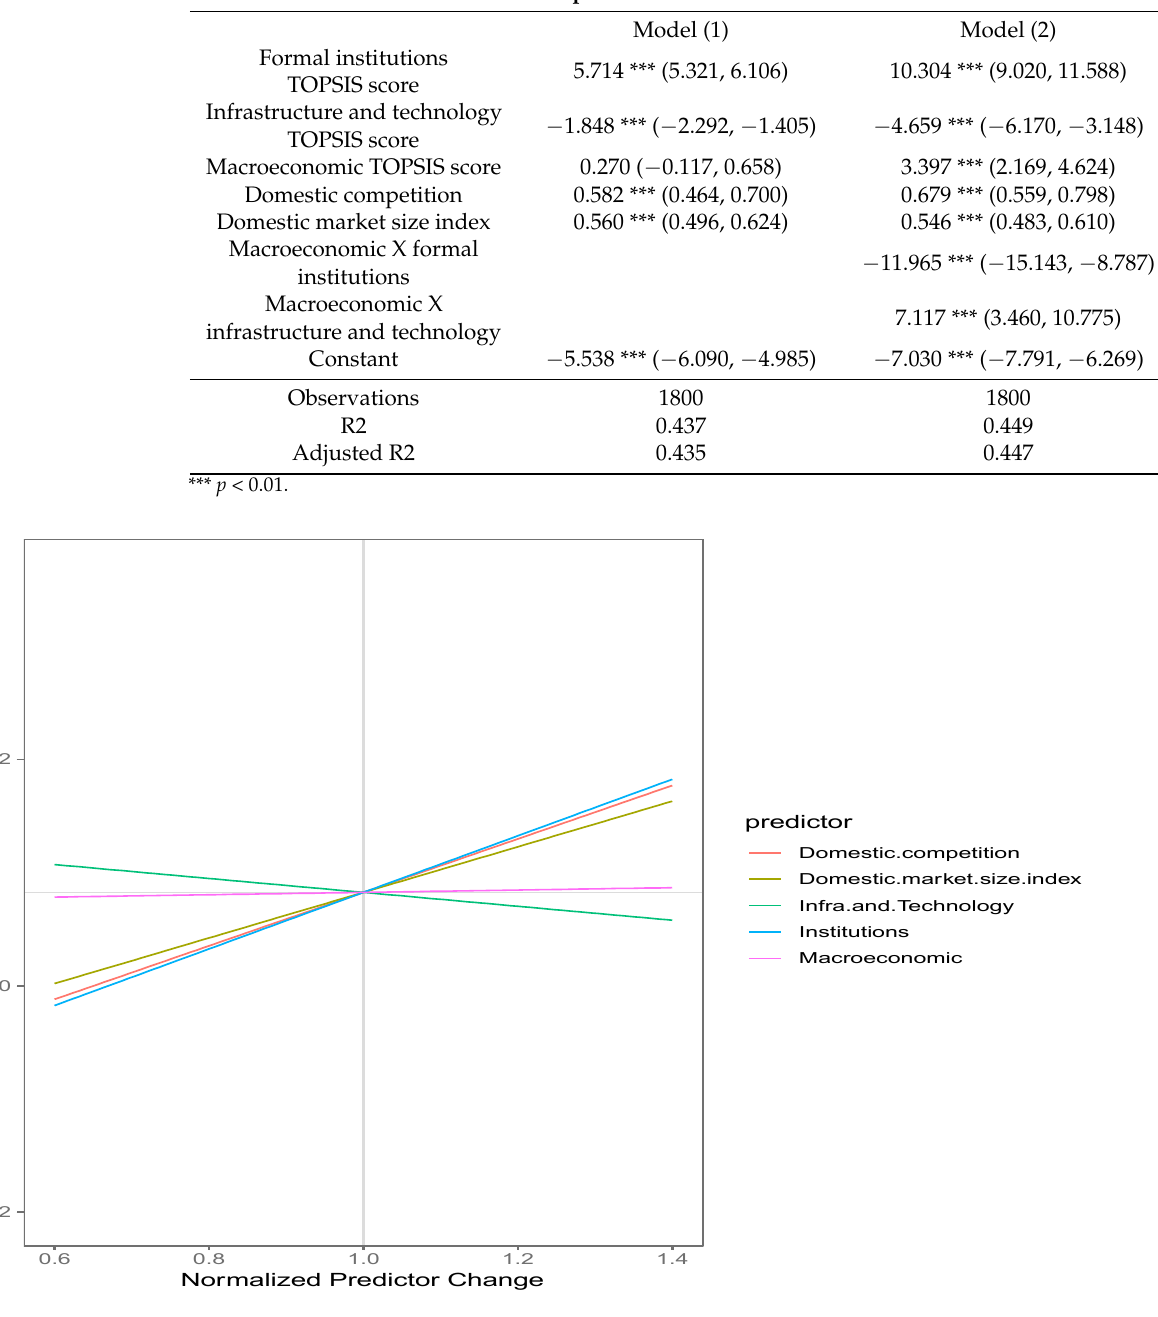
Figure 5. Sensitivity analysis for model (1) with a 90% confidence interval constructed for each pre- dictor.